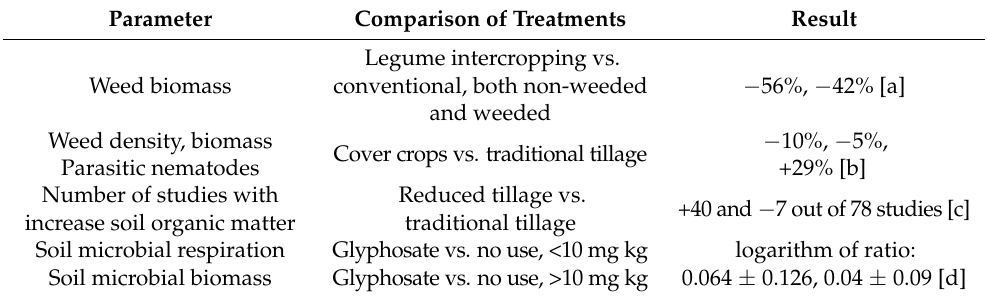
Table 4. Weed management: main effects as reported in meta-analysis studies. See also Table S7. Parameter Comparison of Treatments Result Legume intercropping vs. − 56%, − 42% [a] Weed biomass conventional, both non-weeded and weeded − 10%, − 5%, Weed density, biomass Cover crops vs. traditional tillage +29% [b] Parasitic nematodes Number of studies with Reduced tillage vs. +40 and − 7 out of 78 studies [c] increase soil organic matter traditional tillage Soil microbial respiration Glyphosate vs. no use, <10 mg kg logarithm of ratio: Soil microbial biomass 0.064 ± 0.126, 0.04 ± 0.09 Glyphosate vs. no use, >10 mg kg